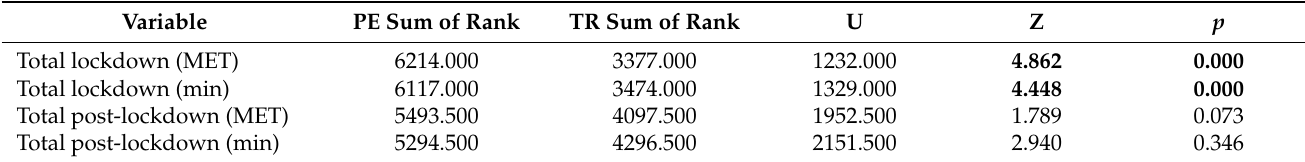
Table 5. Comparison of the amount of physical activity of PE and TR students in the lockdown and post-lockdown period (U Mann–Whitney test).